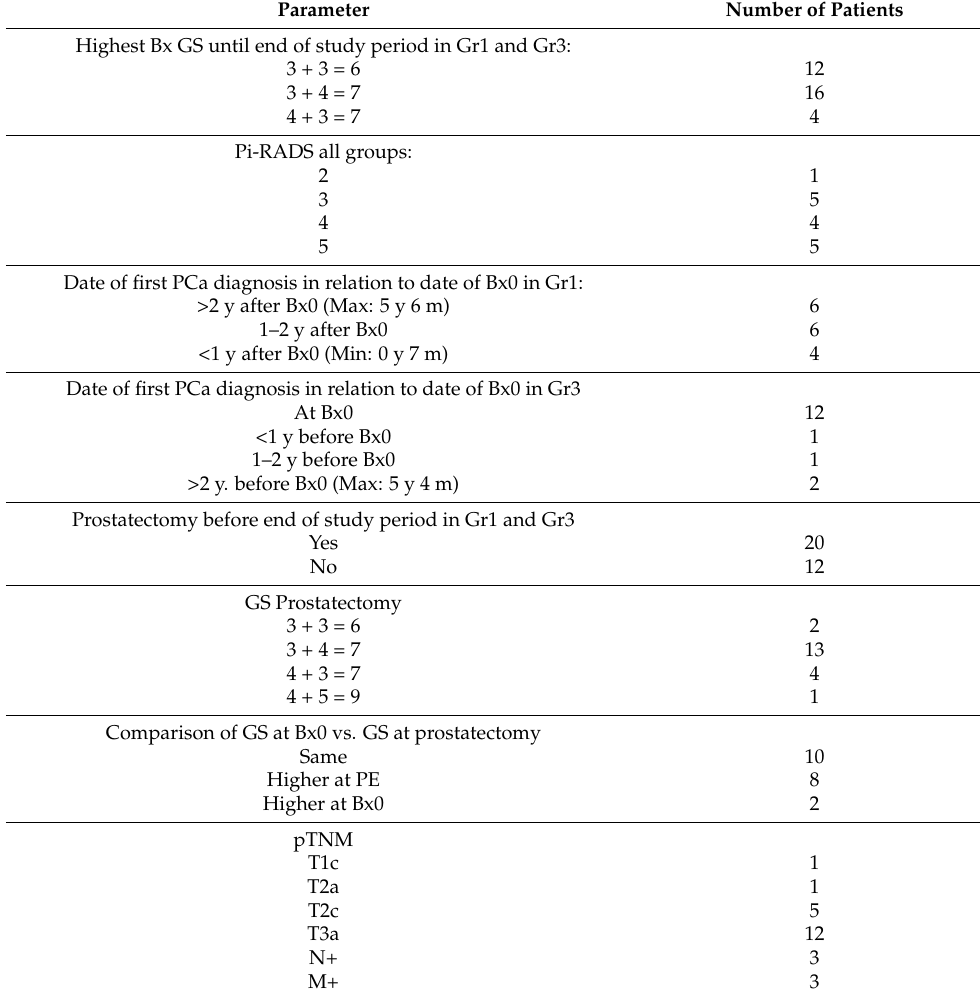
Table 2. Further clinical and pathological patient data. Parameter Number of Patients Highest Bx GS until end of study period in Gr1 and Gr3: 3 + 3 = 6 12 3 + 4 = 7 Pi-RADS all groups: 2 1 3